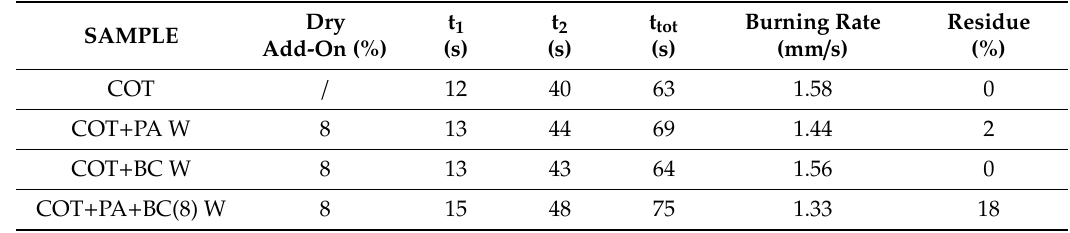
Table 6. Horizontal flame spread tests performed on cotton and on selected flame retardant (FR) treated samples after